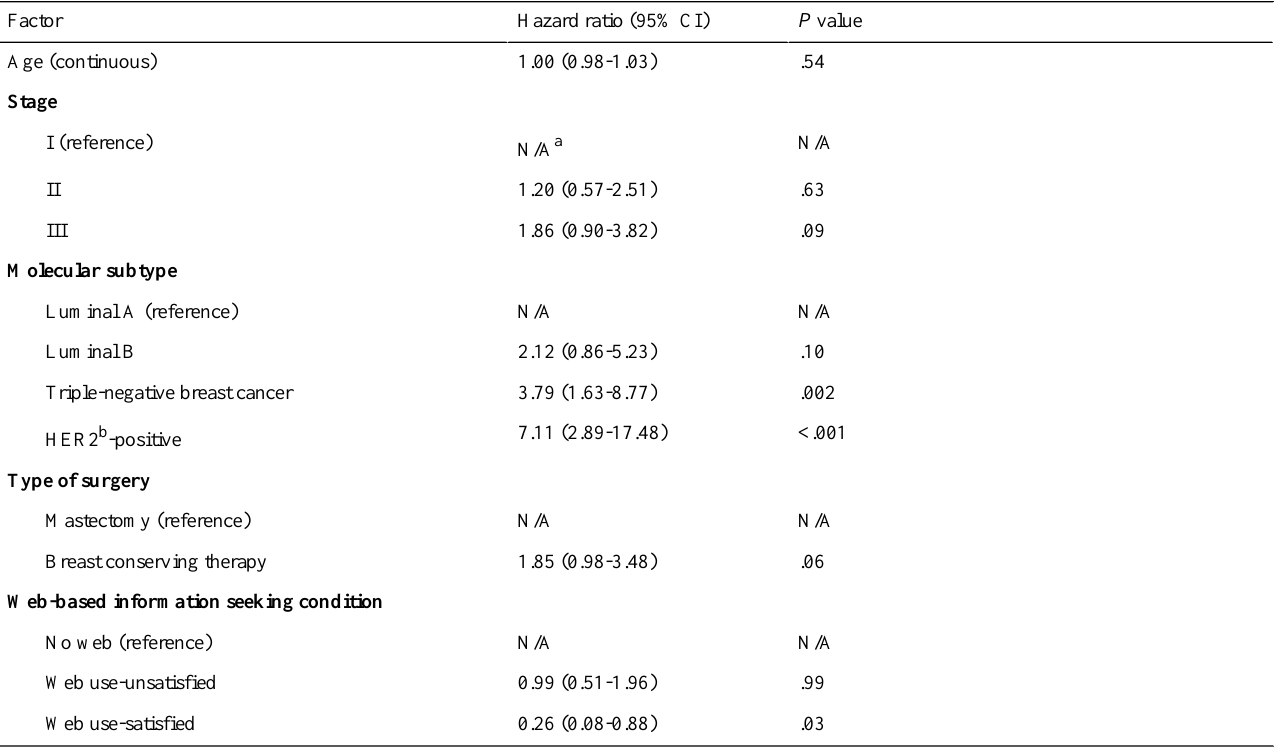
Table 4. Cox proportional hazards regression model analysis of disease-free